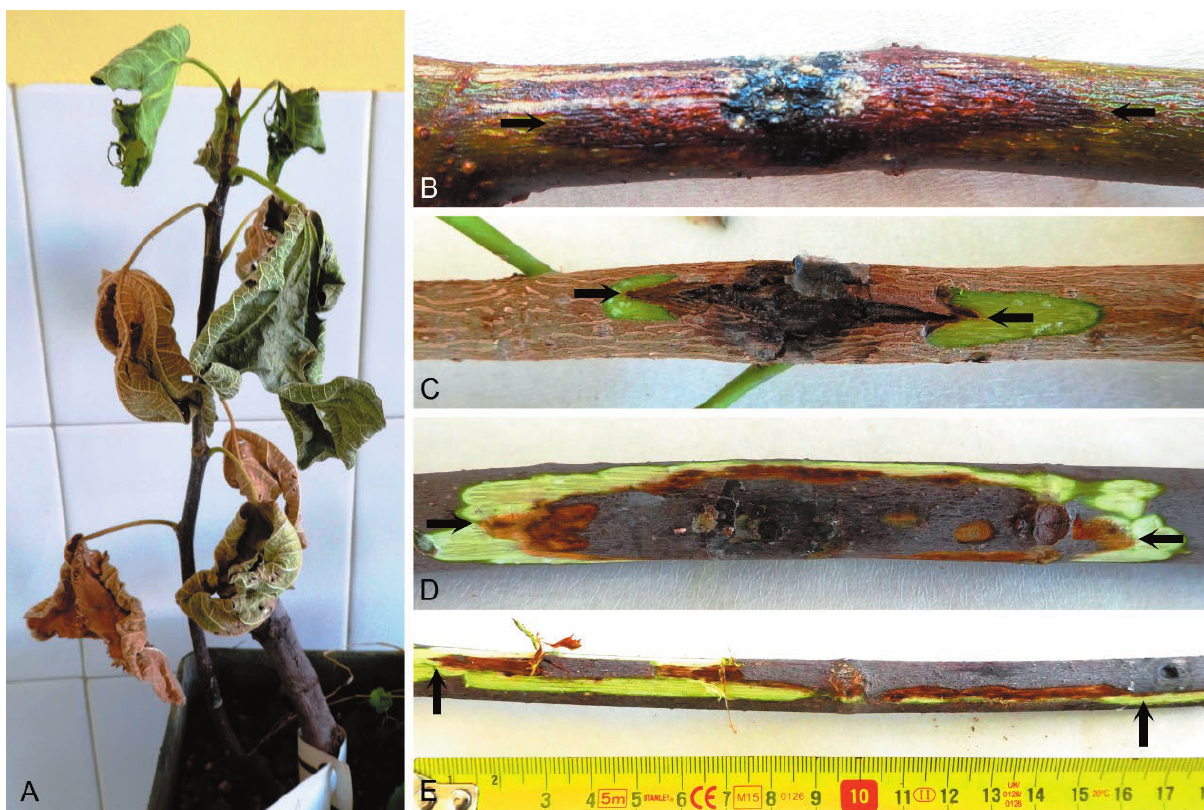
Figure 4. Inoculations with Ceratocystis ficicola . A, Ficus carica symptoms of leaf wilt 6 weeks after inoculation; B, canker formed on a branch twig of F. carica 5 weeks after inoculation; C, canker formed on a branch twig of F. benjamina 6 weeks after inoculation; D and E, main stem of a F. carica sapling with xylem discolouration extending longitudinally beyond the necrotic bark 6 weeks after inoculation. Arrows in E show the edges of the lesion.